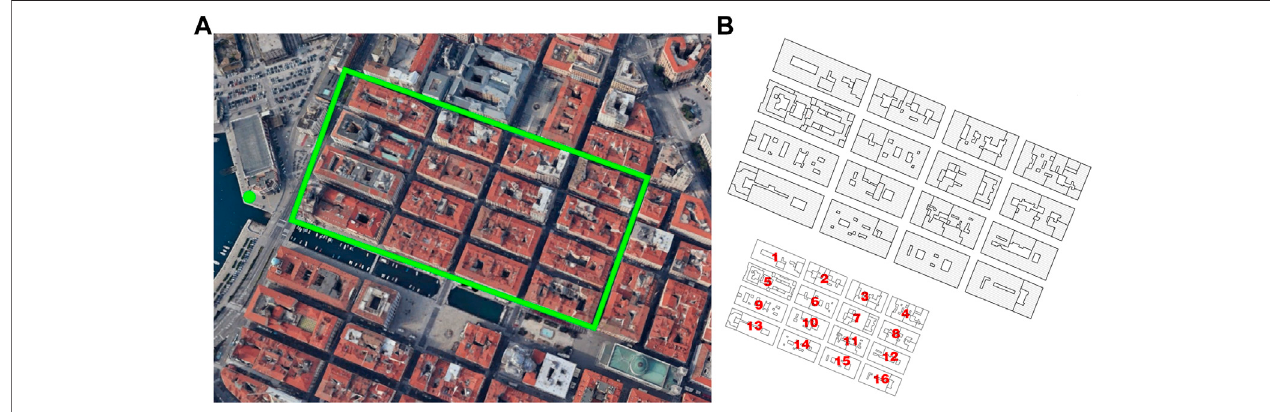
FIGURE 1 | The investigated area: a photograph (A) and a map of the blocks in the area, numbered as indicated in panel (B) .